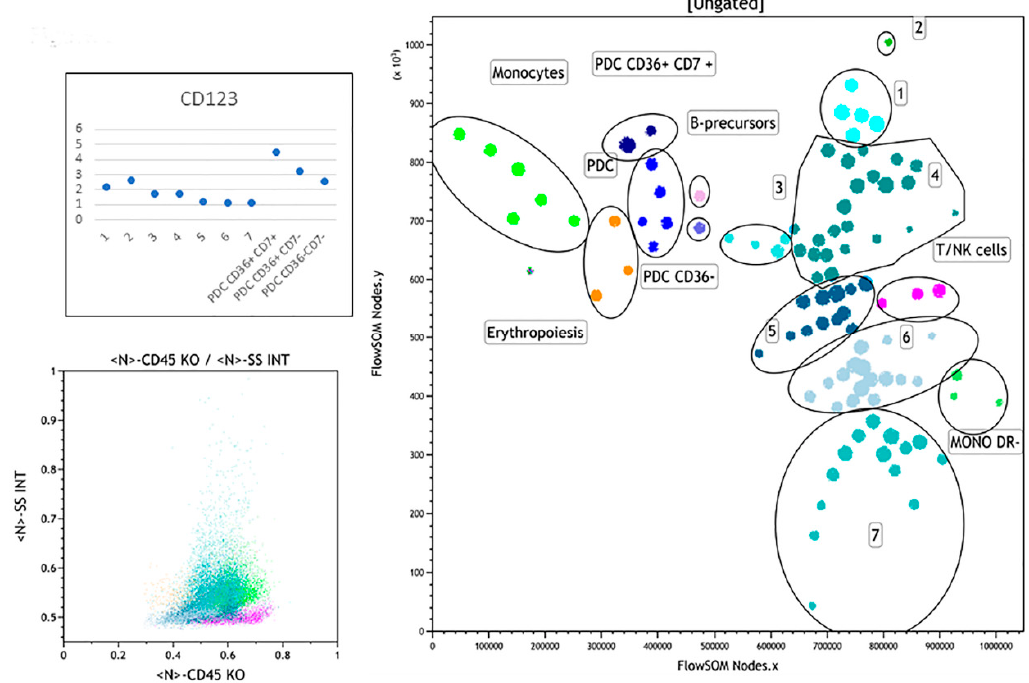
Figure 8. FlowSOM analysis of Case 7. Minimal spanning tree, in the right panel, shows a heavily infiltrated BM as exemplified on the CD45/SSC scattergram ( bottom left ). The blast population is segregated by FlowSOM in seven progenitor subsets (Supplementary Table S10) and, even more surprisingly, eight PDC subsets (shades of dark blue), four of them being characterized by the absence of CD36 expression and two by the presence of CD7. Normalised MFI of CD123 expression in numbered blast subsets and PDCs is illustrated in the upper left diagram.